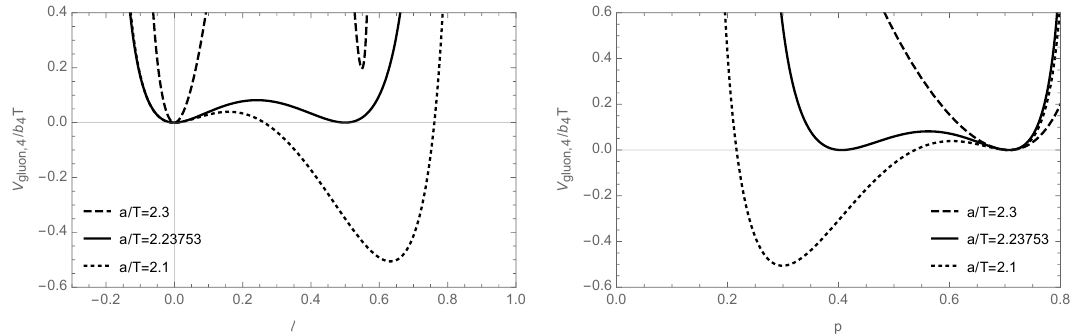
Figure 2 . The potential V gluon ; 4 ( L; T ) =b 4 T as a function of ‘ (left) and of p (right) on the straight line linking the two minimum points given in (3.28) and (3.29) around the critical temperature ~ a c = a=T c = 2 : 237527. Note that along the line ‘ increases while p decreases. where x = cos (cid:18) and x = cos (cid:18) , and V 0 ( L ) is given 1 1 2 2 gluon ; 4